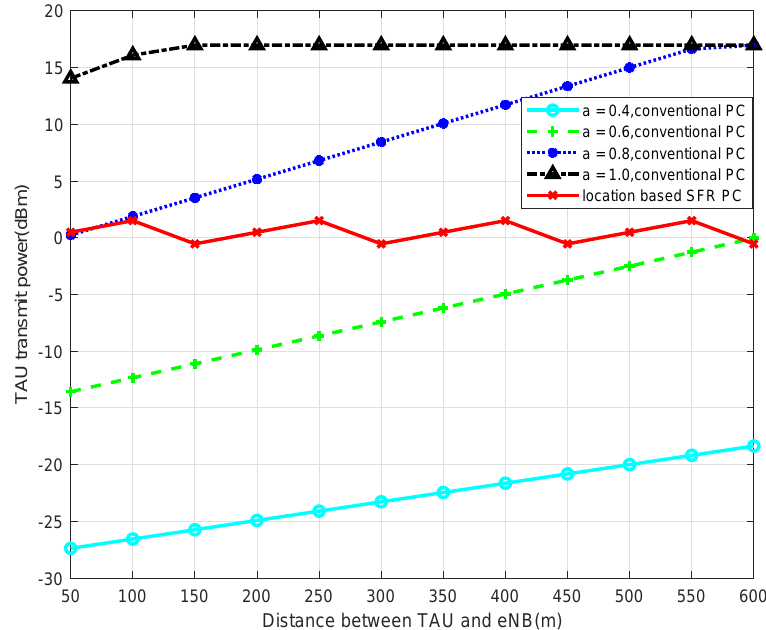
Figure 6. Transmit Power of TAU in 8-SFR.